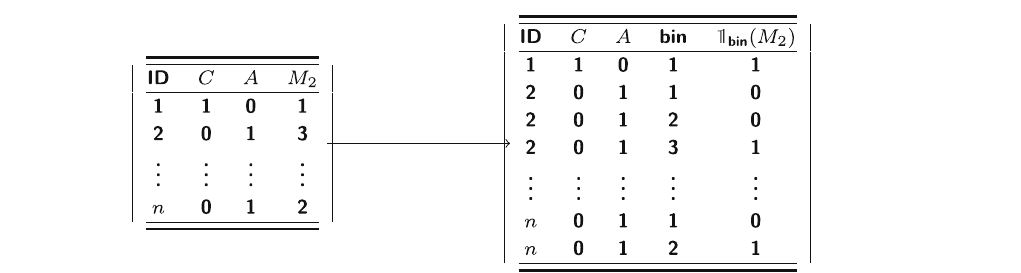
An ID is uniquely assigned to each independent data unit and a single confounder C is included in the mock data